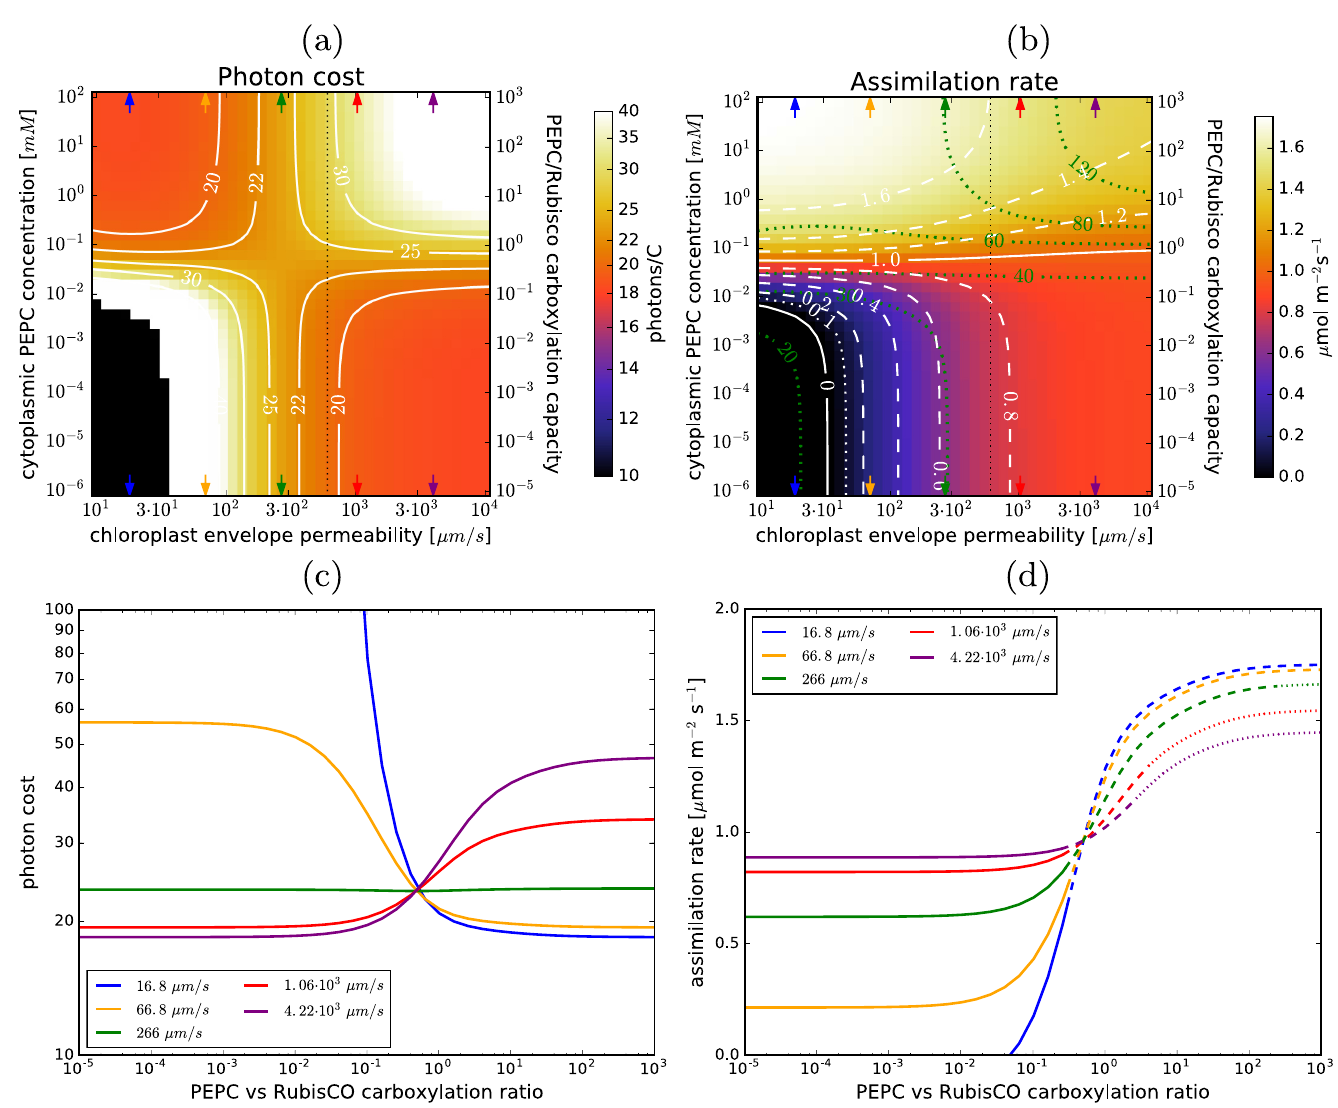
Fig 2. Envelope permeability and C 4 photosynthesis. (a) and (b): The photon cost and the net assimilation rate as functions of the envelope permeability and PEPC concentration in the cytoplasm for the default parameter choice (Table 1). Level-lines are in white. The green lines in (b) mark the light-utilisation thresholds (in mol m -3 s -1 ). In the black regions the photon cost and the assimilation rate are negative. The black vertical dotted line marks the envelope permeability used as default in other figures. Note the double y-axes for the PEPC cytoplasmic concentration and the PEPC/RubisCO carboxylation ratio. (c): Dependence of the photon cost on the PEPC-vs-Rubisco carboxylation capacity ratio for several envelope permeability values (marked with arrows in (a) and (b)). (d): The corresponding dependence of the assimilation rate. The lines become dashed (dotted) where the required light-harvesting capacity exceeds 40 mol m -3 s -1 (80 mol m -3 s -1 ).